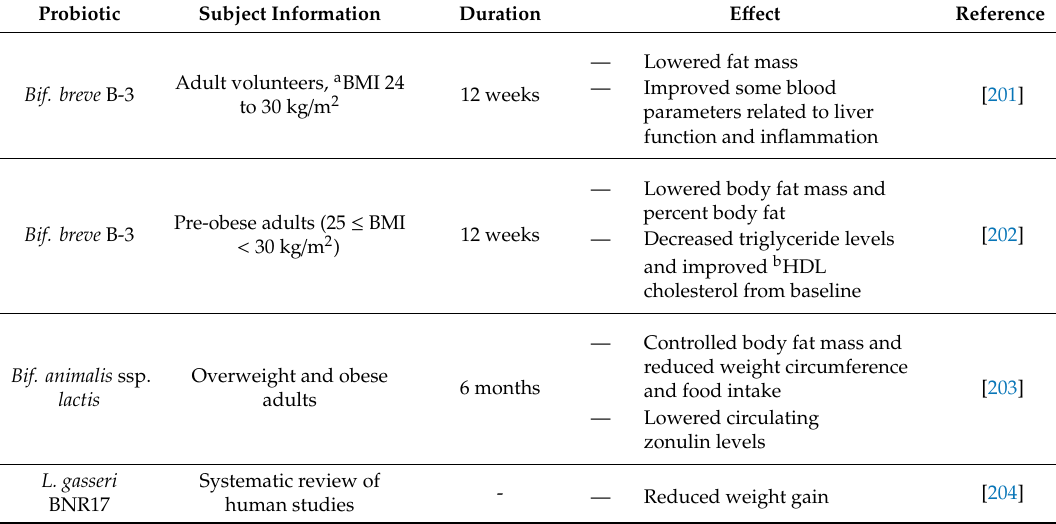
Table 2. Impact of probiotics on overnutrition in human intervention